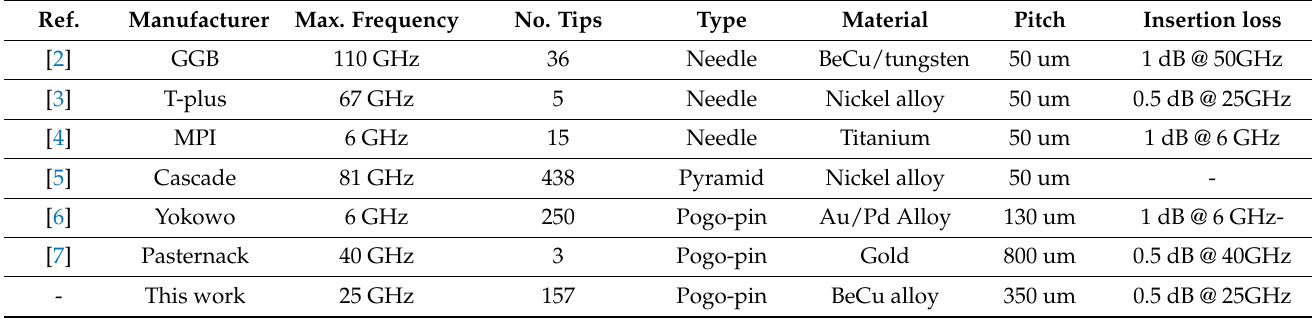
Table 1. List of commercially available multiple-port RF probes.